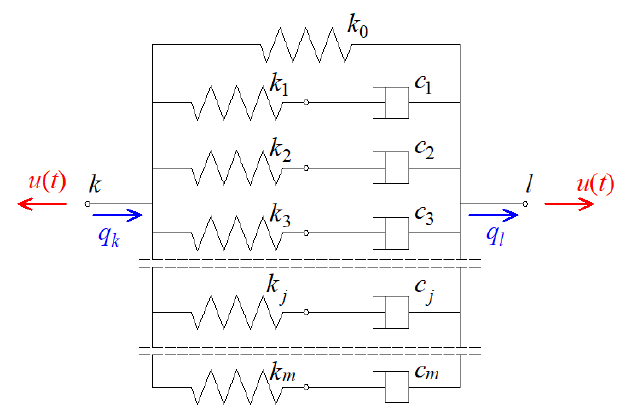
Figure 2 . Generalized Maxwell model of viscoelastic damper. Figure 2. Generalized Maxwell model of viscoelastic